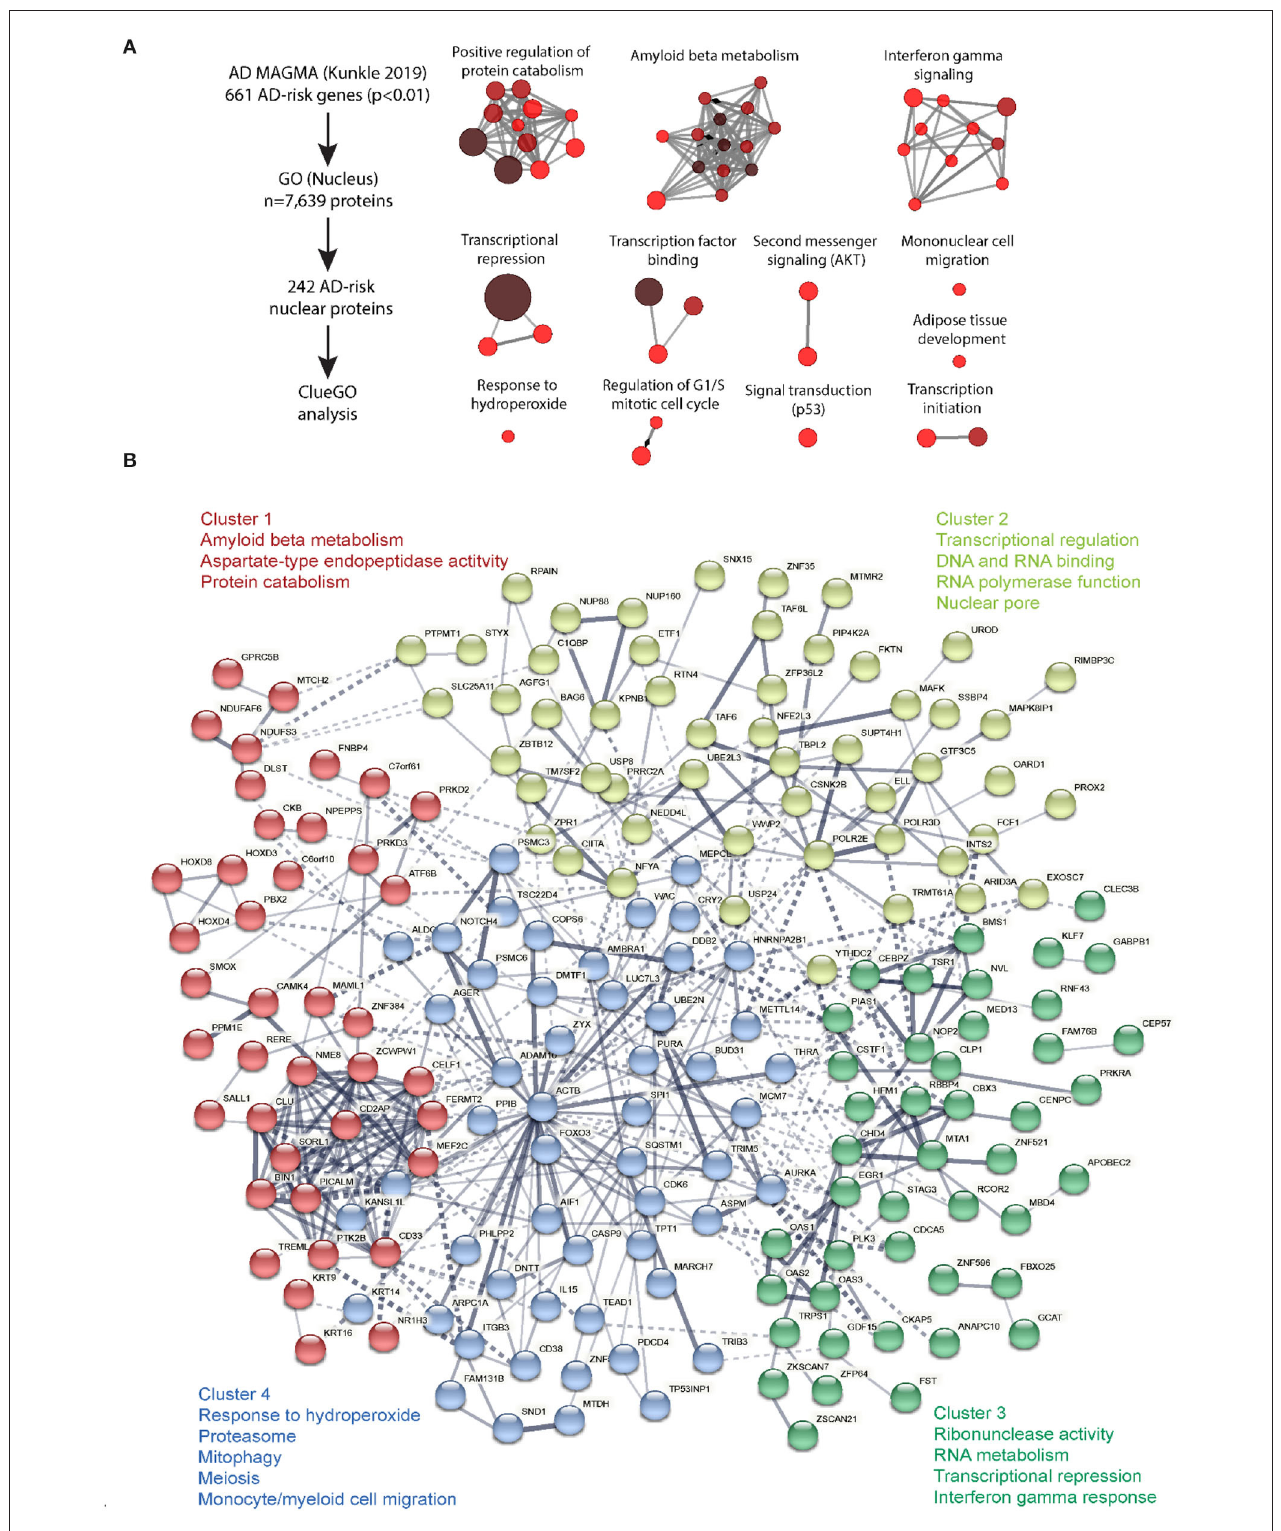
FIGURE 2 | ClueGO analysis of cell-type specific proteome. Molecular mechanisms regulated by nuclear-expressed proteins of AD relevance. (A) ClueGO analysis was performed on the 242 proteins encoded by AD risk genes as identified by MAGMA analysis of human AD GWAS (Kunkle et al., 2019), and with known nuclear function (based on GO Nucleus term membership). This analysis identified 12 clusters of biological and molecular processes. Each node represents a GO term and